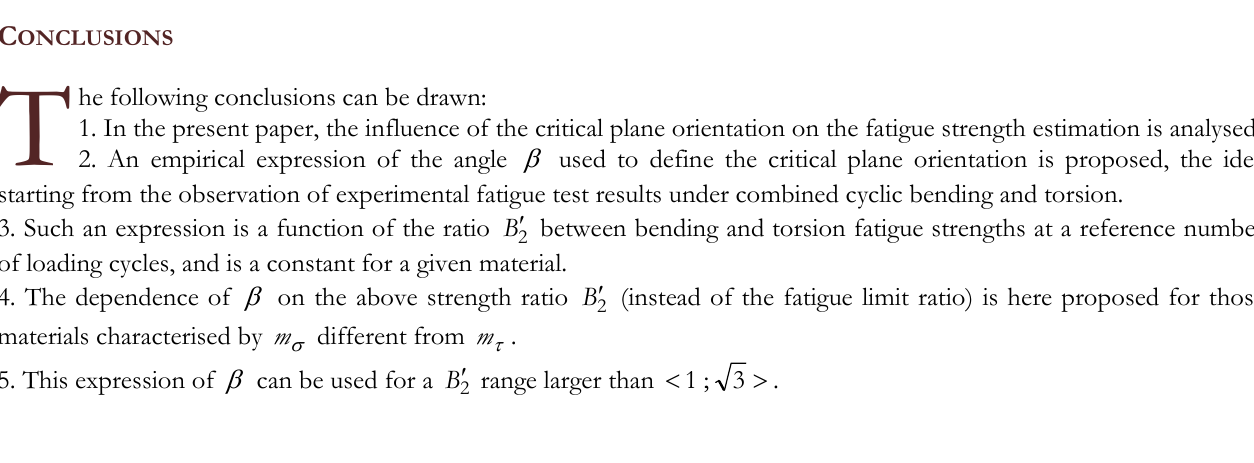
B by employing Eq. (18). The value of  in correspondence of the minimum value of the scatter is also 2